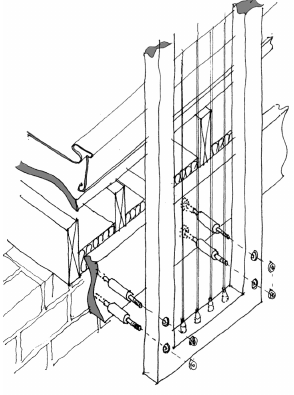
Figure 13. Balustrade Assembly Detail 2005 Bates Zambelli Architects [49].